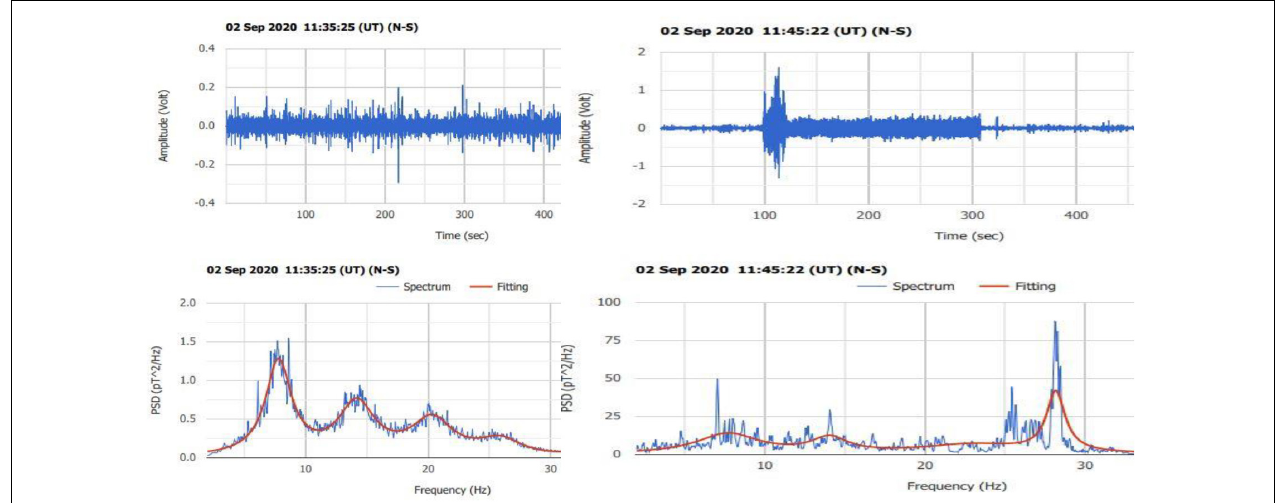
FIGURE 9 | Right panel : the peculiar features are due to a running car engine. Left panel : undisturbed SR spectrum 10 min before the car engine ignition.